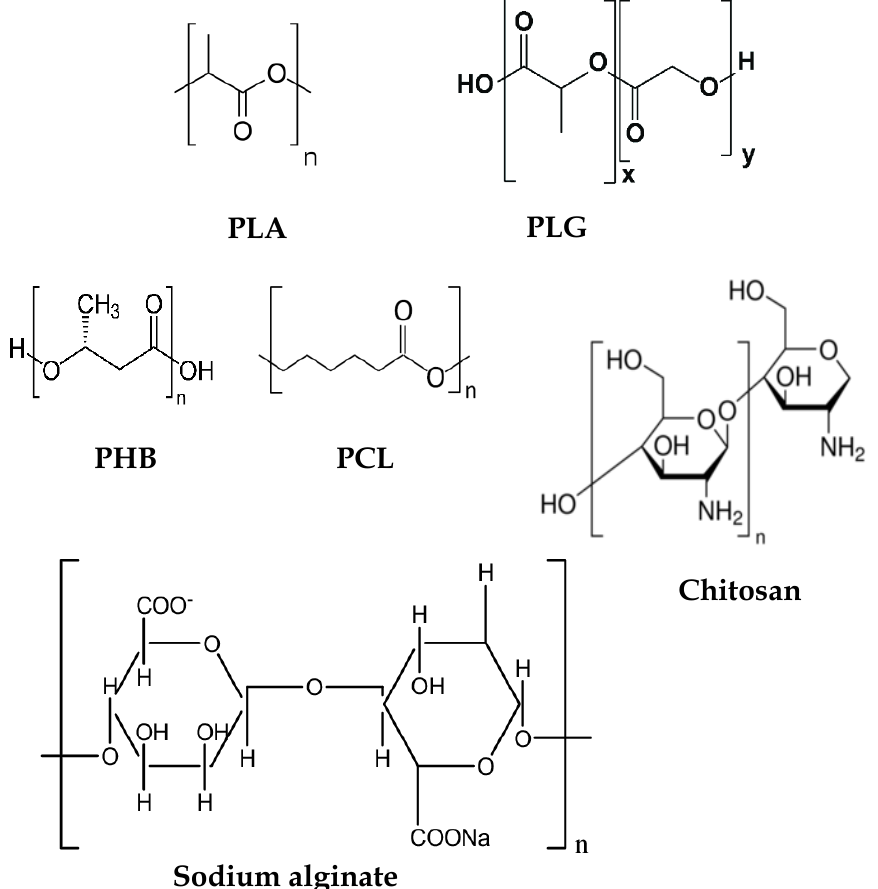
Figure 11. Chemical structure of some biocompatible polymers such as polylactic acid (PLA), poly (lactic-co-glycolic acid) (PLGA), polyhydroxybutyrate (PHB), polycaprolactone (PCL), chitosan, and sodium alginate.